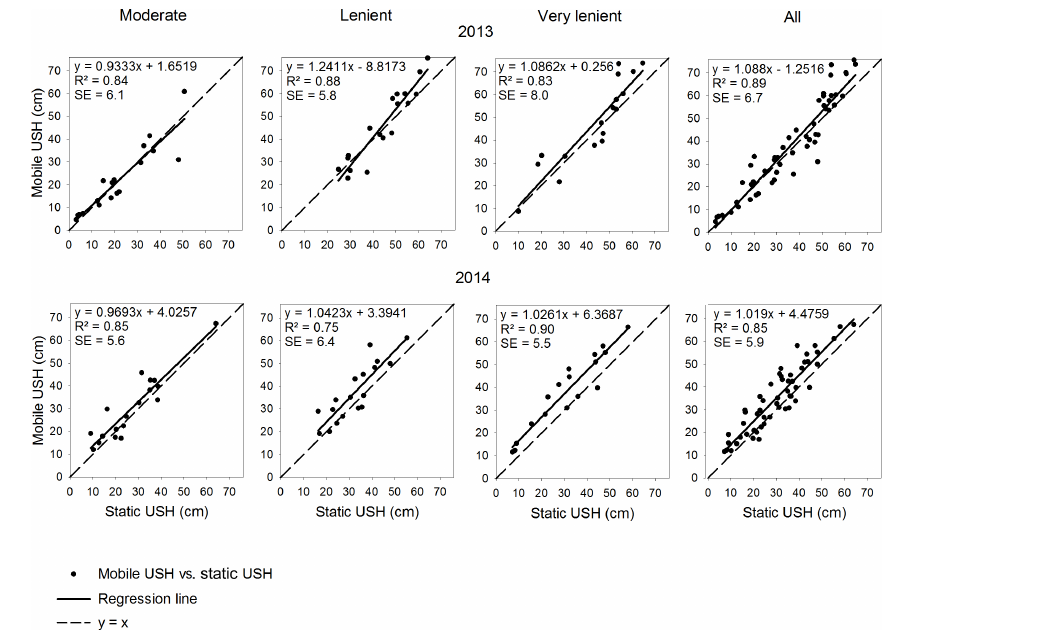
Figure 3. Relationship between mobile- and statically measured ultrasonic sward height (USH) (cm). Both measurements were conducted on reference plots in pastures differently stocked with animals in 2013 and